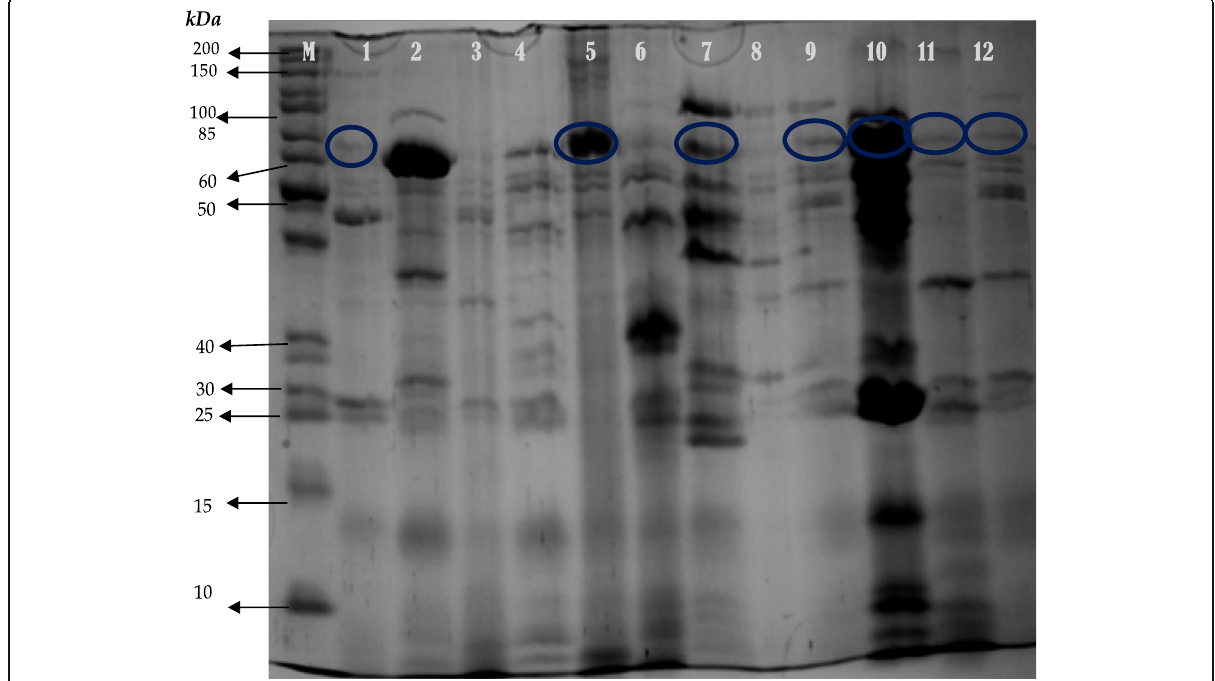
Fig. 6 Sodium dedocyle sulfate polyacrylamide gel electrophoretic pattern of total proteins of sporulated Bt. The lanes from left to right show protein pattern of native Bt aphidicidal Isolates. M — PageRuler ™ Unstained Protein Ladder (10 to 200 kDa), Lane1 — BNG_Bta1, Lane2 — SHVM_Bta2, , Lane3 — MYS_Bta3, Lane4 — VJP_Bta4 , Lane5 — DVG_Bta5, Lane6 — CMR_Bta6, Lane7 — GLB_Bta7, Lane8 —